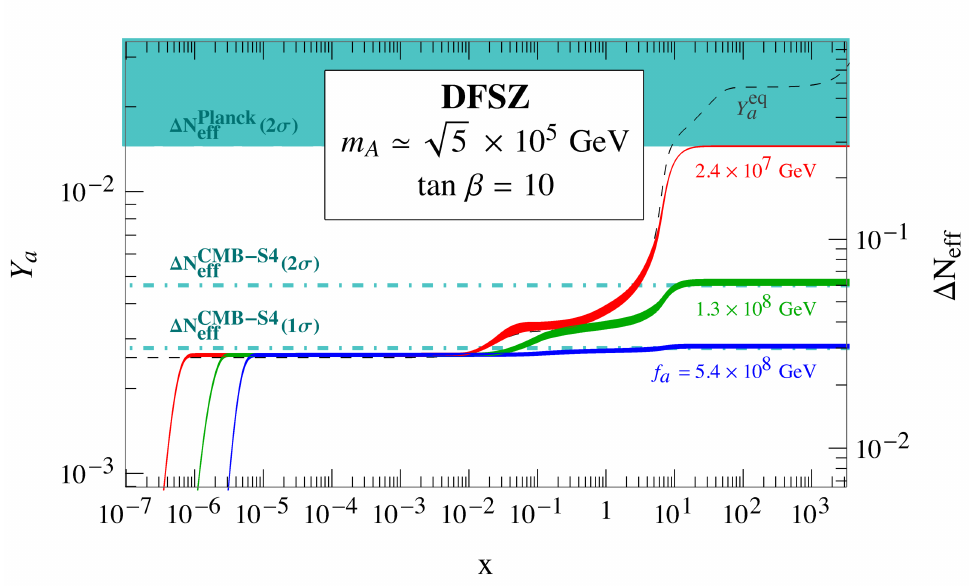
Figure 10 . Axion comoving number density Y a as a function of x = GeV /T for the DFSZ frame- work. Notation as in figure